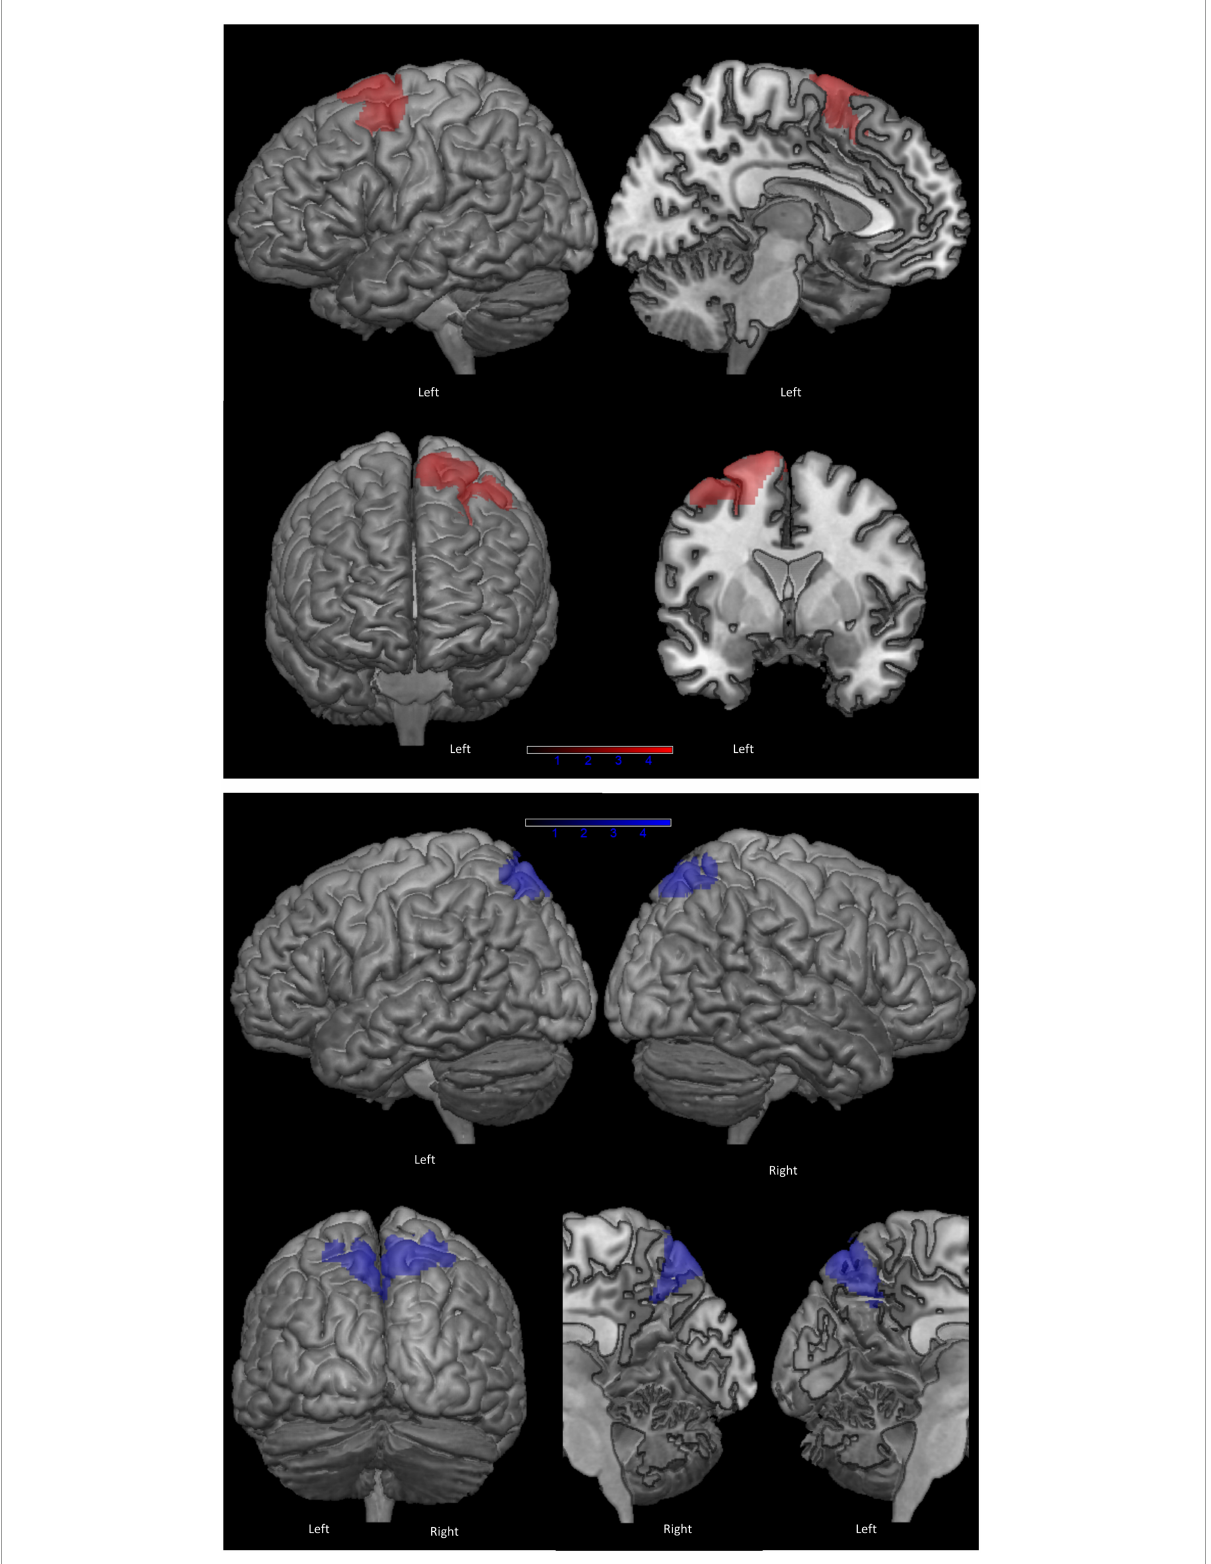
FIGURE2 Clusters of hypometabolism correlated with phonemic fluency (in red) and with copy of Rey-Osterrieth Complex Figure (ROCF), as control task (in blue) ( p < 0.001 uncorrected, minimum cluster size: 100